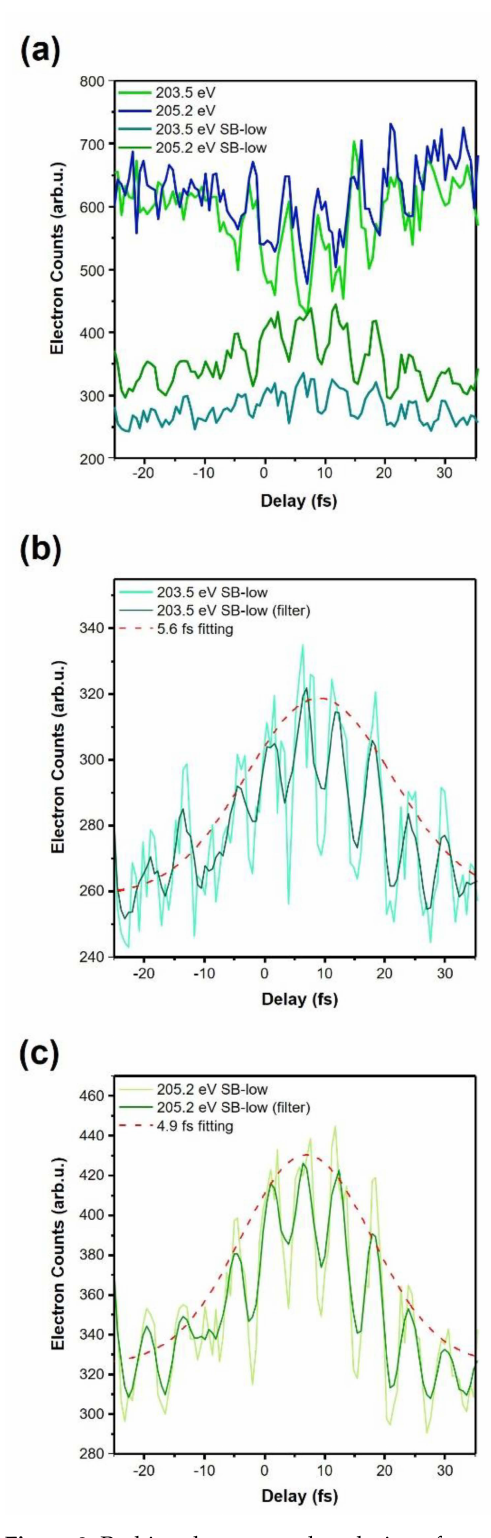
Figure 8. Probing the temporal evolution of argon Auger electron emission. ( a ) Measured electron counts of two strong Auger peaks and corresponding sidebands along the delay. ( b ) The extracted argon Auger decay time of 203.5 eV Auger peak from the sideband of 202.8 eV. ( c ) The extracted argon Auger decay time of 205.2 eV Auger peak from the sideband of 204.5